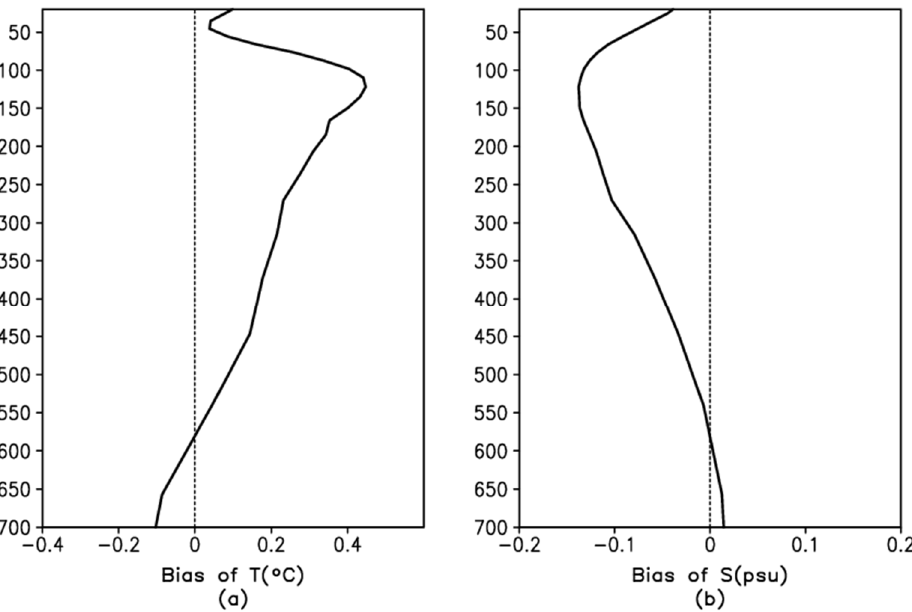
Figure 1. Vertical profiles of the 1993–2005 mean differences between the simulations and the ob- servations, averaged over the model domain for ( a ) temperature, ( b ) salinity. observations, averaged over the model domain for ( a ) temperature, ( b )